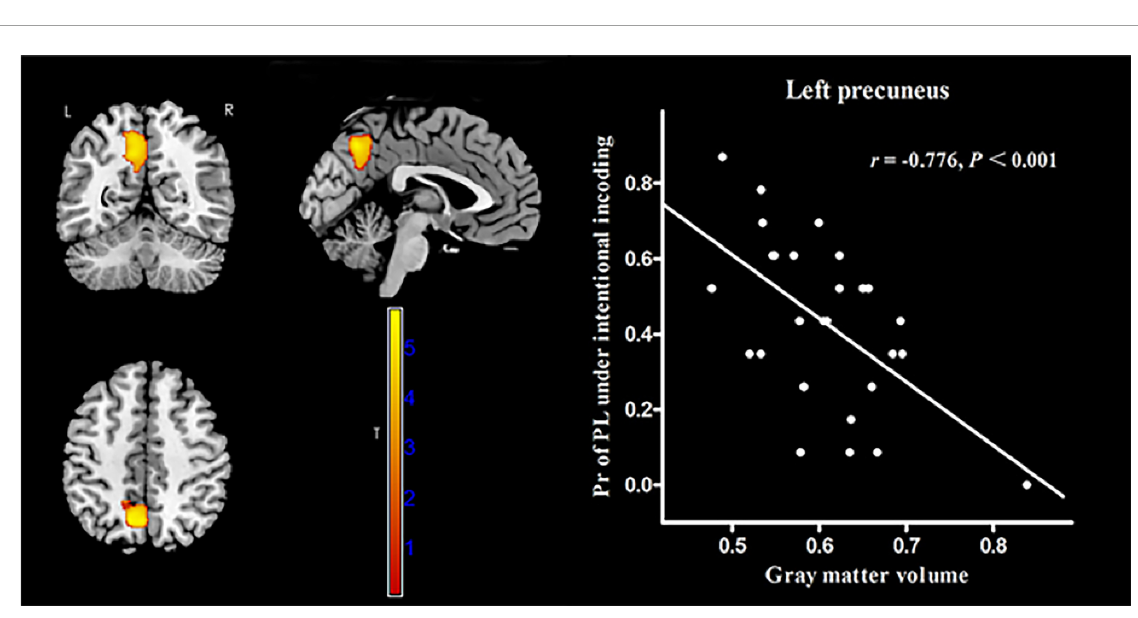
FIGURE5 Correlation between voxel-wise gray matter volume in the left precuneus and the Pr-PL (positive stimulus with low arousal) under intentional encoding in MWoA patients. p < 0.05, cluster-level FWE corrected. Scatter plot of ROI-based partial correlation analysis between gray matter volume in the left precuneus and the